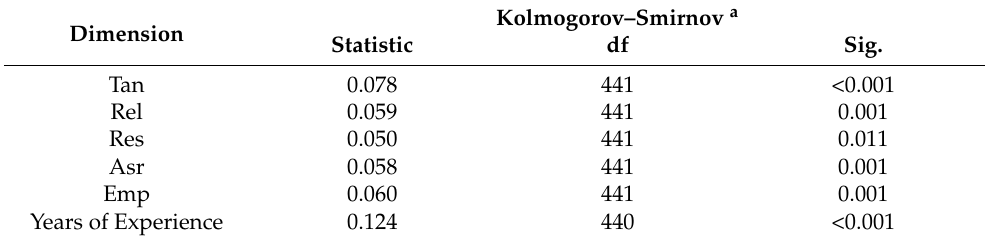
Table 2. Normality tests for Quality Dimensions and “Years of Experience”. Dimension